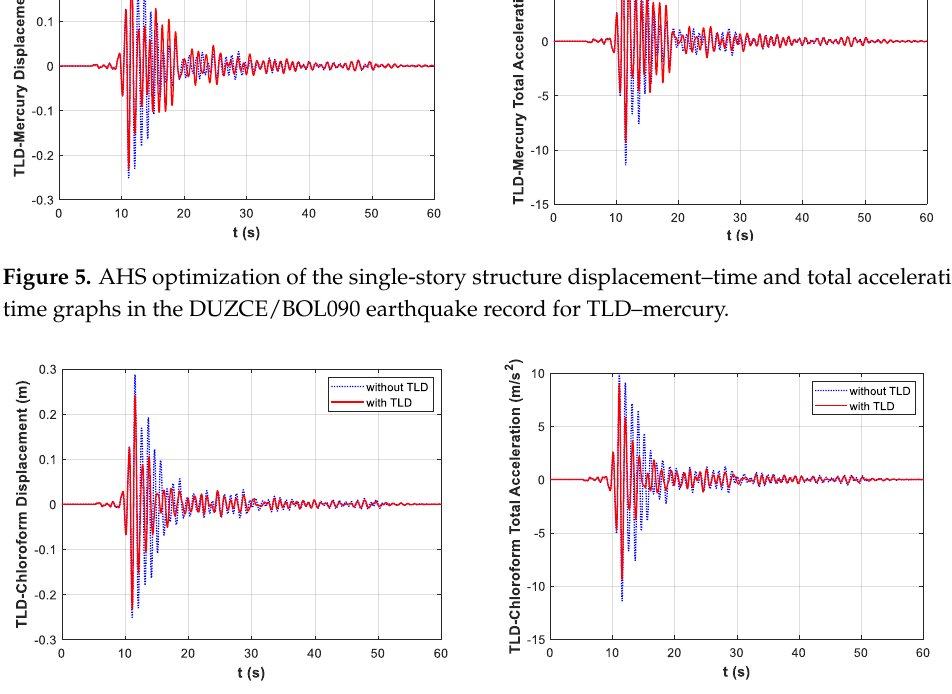
Figure 6. AHS optimization of the single-story structure displacement – time and total acceleration – time graphs in the DUZCE/BOL090 earthquake record for TLD – chloroform.